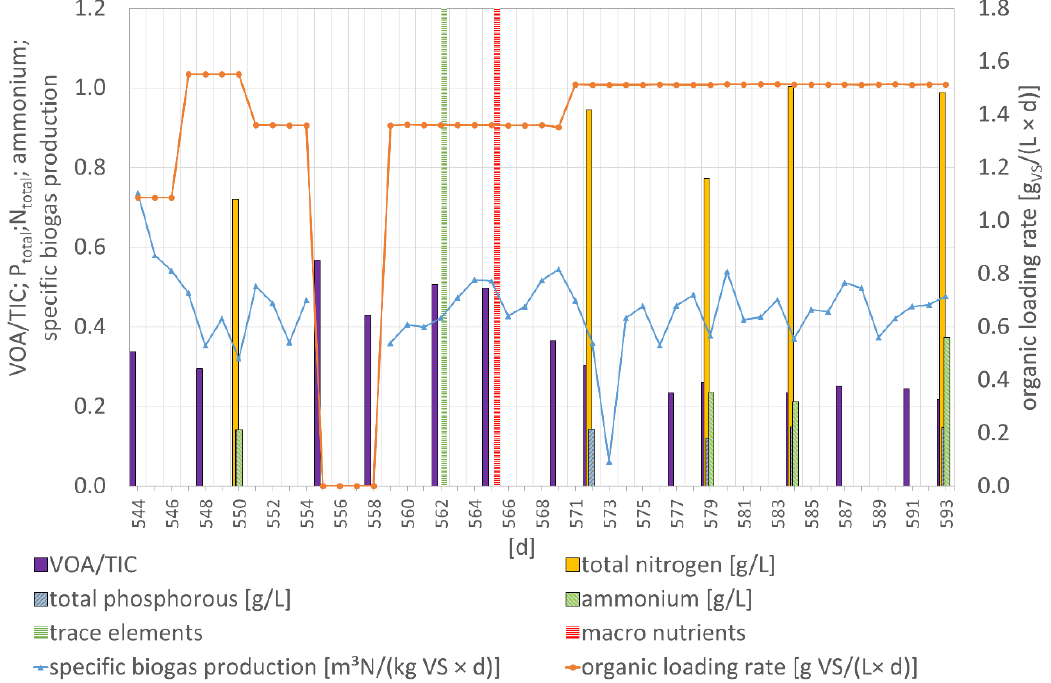
Figure 3. Specific daily biogas production, VOA/TIC, total phosphorous, total nitrogen, ammonium, and organic loading rate of the continuous biogas process (40 °C; pH 7.0–8.0, lot B). The days of macronutrient and trace element supplementation are marked.